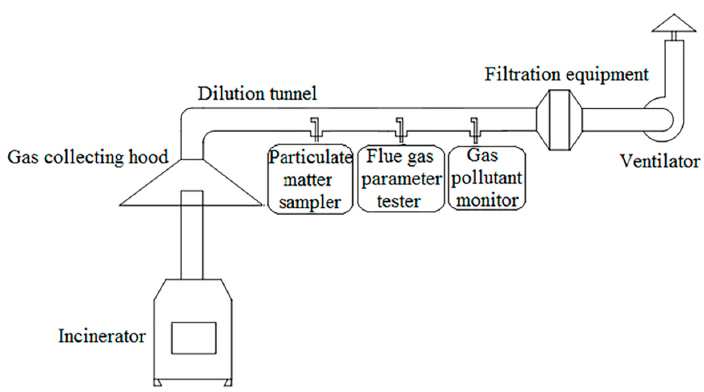
Figure 2. Four types of sacrificial offerings used in the experiment.